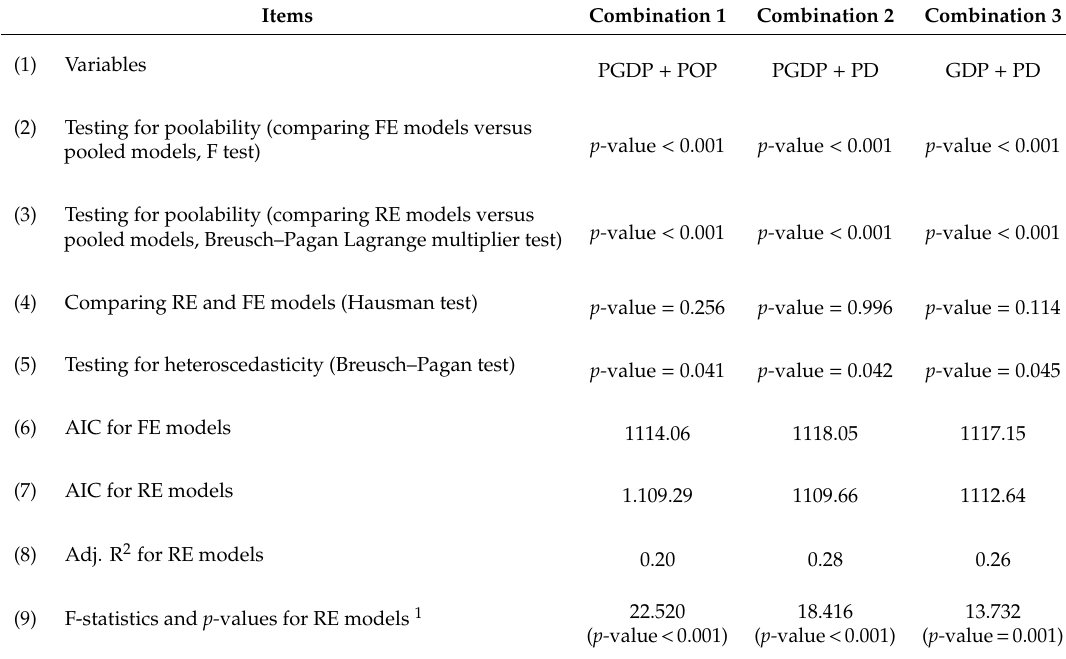
Table 1. Testing results and model statistics.